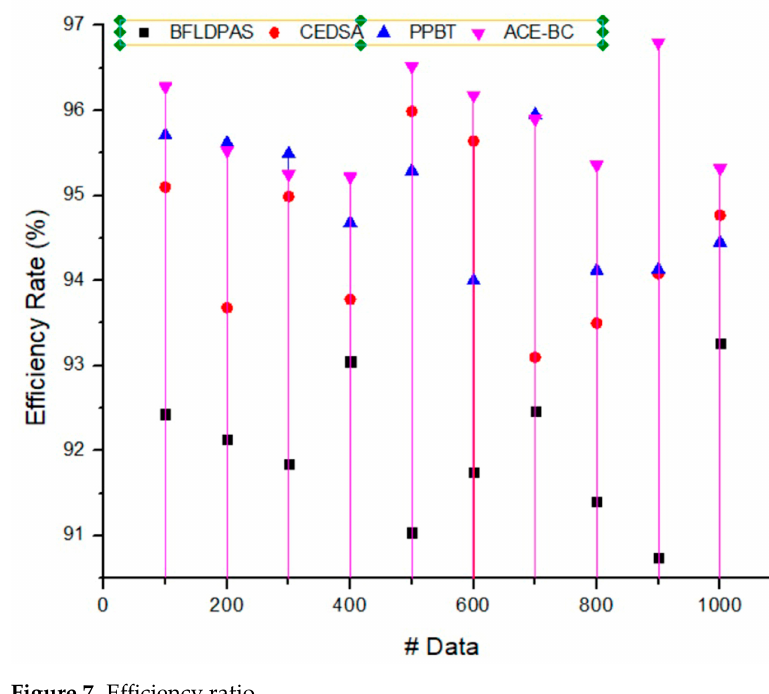
Figure 7. Efficiency ratio.